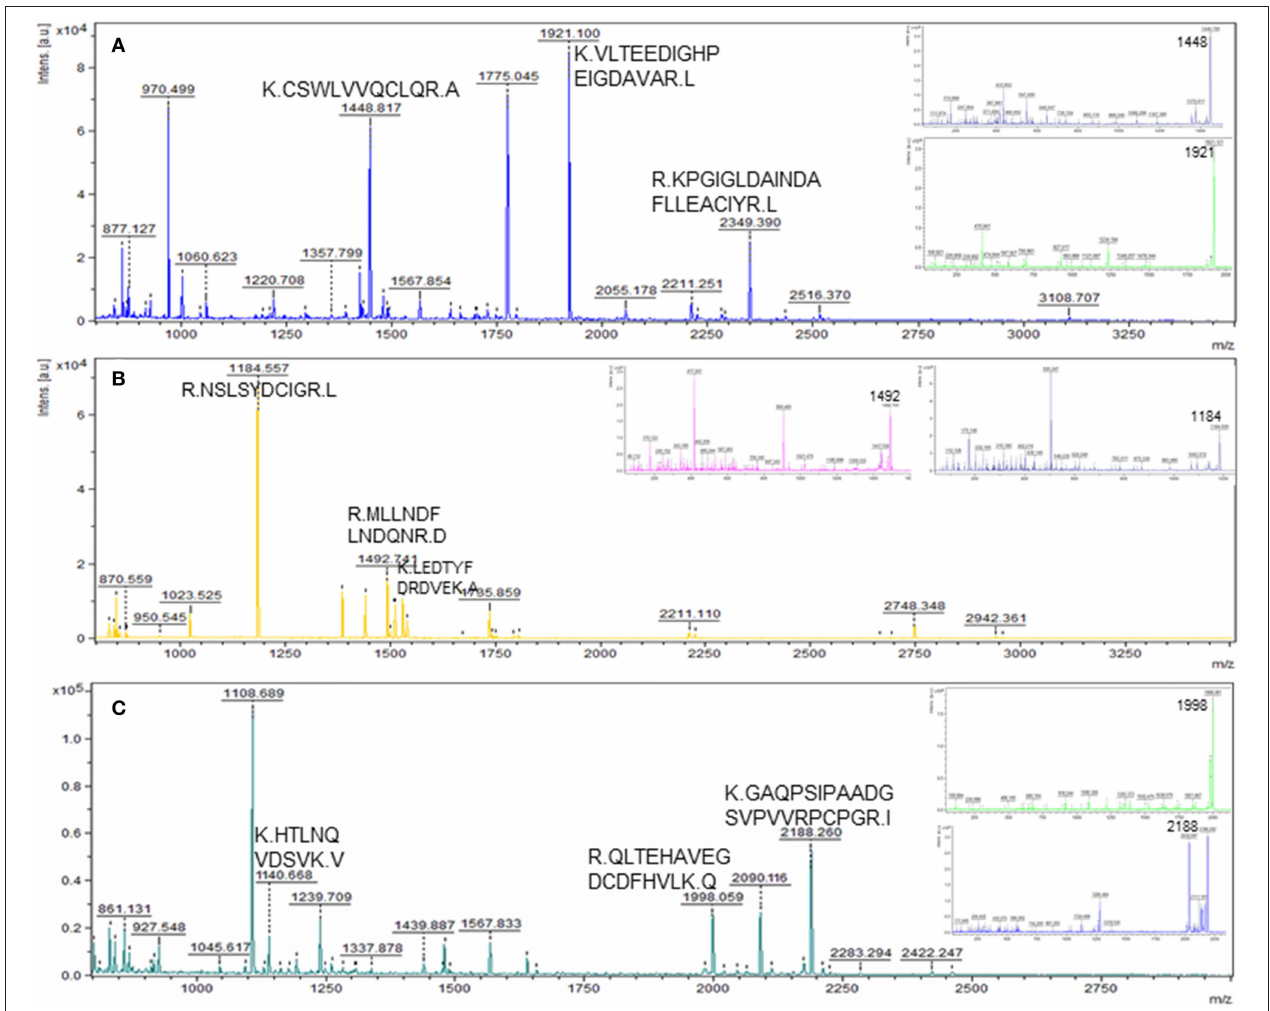
FIGURE 3 | Representative MS and MS/MS (insets) spectra of some of the novel differentially abundant proteins in the CL as compared to POF. Matched peptides with a significant ion score of > 30 are shown. (A) Peptides KCSWLVVQCLQRA, KVLTEEDIGHPEIGDAVARL, and RKPGIGLDAINDAFLLEACIYRL matched to protein FDPS; (B) peptides RNSLSYDCIGRL, RMLLNDFLNDQ NRD, and KLEDTYFDRDVEKA matched to protein HMGCS1; (C) peptides KHTLNQVDSV KV, RQLTEHAVEGDCDFHVLKQ, and KGAQPSIPAADGSVPVVRPCPGRI matched to protein